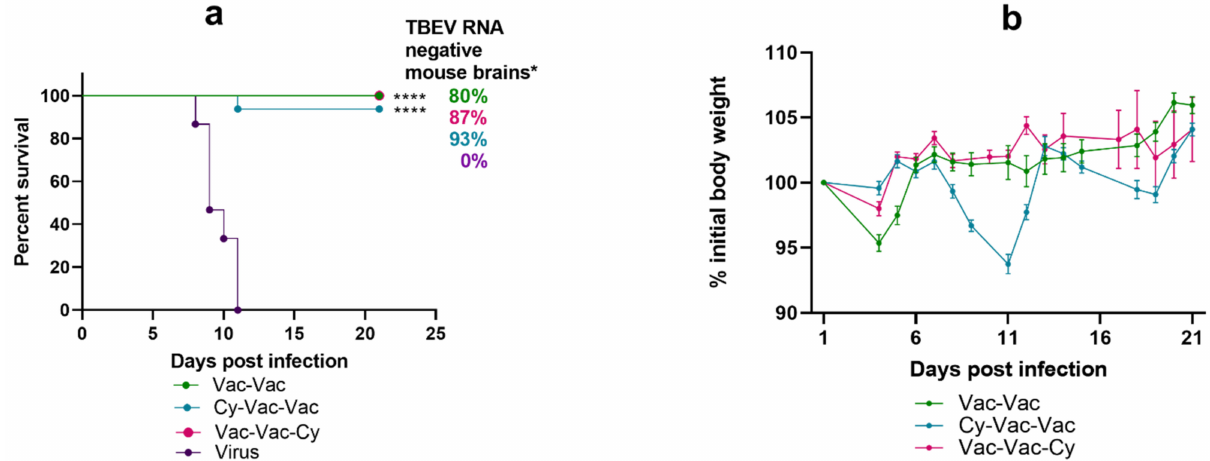
Figure 2. Survival and weight changes in BALB/c mice with and without low-dose Cy immunosupression. Mice were vaccinated with TBE vaccine Tick-E-Vac and challenged with 100 LD 50 of TBEV strain Vasilchenko. ( a ) Survival curves for vaccinated and control mice. ( b ) Weight changes after the virus challenge. Error bars represent SEM. Group Vac-Vac was vaccinated twice without Cy treatment (green); group Cy-Vac-Vac received Cy before the first vaccine dose (blue); group Vac-Vac-Cy received Cy after the vaccination and immediately before the challenge (pink); Virus—a control non-vaccinated group (violet). In all vaccinated groups, the vaccine was i/m administered twice (50 mkl/mouse) with a two-week interval; the virus challenge was carried out two weeks after the second vaccination. Cy was i/p administered twice at doses 60mg/kg and 30 mg/kg with a one-day interval. For all groups, N = 15. Data only for mice surviving till 21 dpi was used for weight curves. * All brain samples from dead mice were considered RNA-positive. Statistical significance for mortality data was determined by log rank test (**** p <